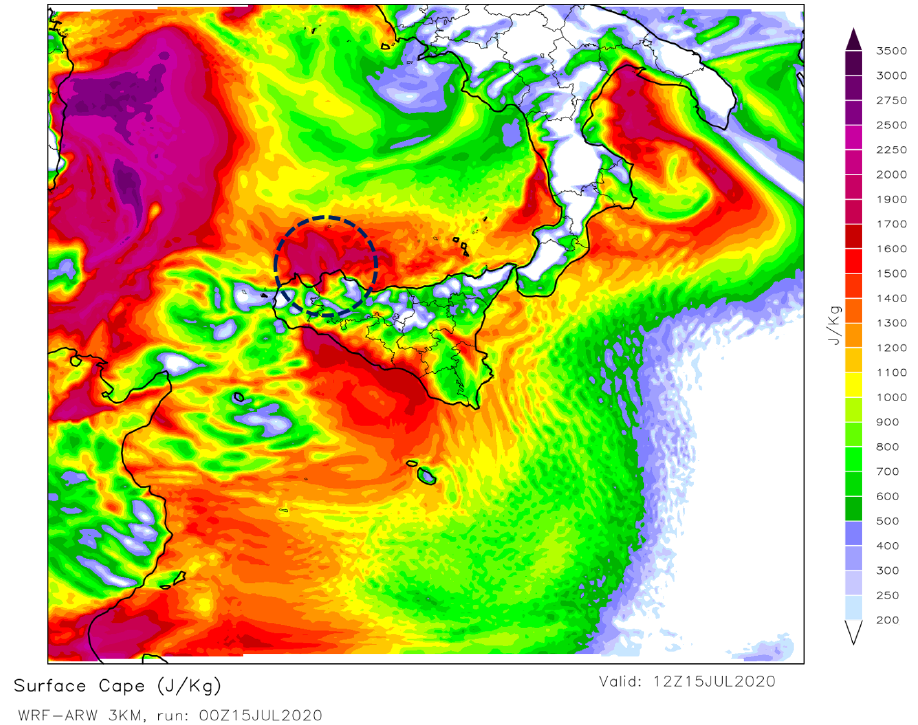
Figure 11. The area of enhanced CAPE near Palermo for 12:00 UTC of 15 July 2020, as simulated by the 3-km grid-spaced WRF configuration, is